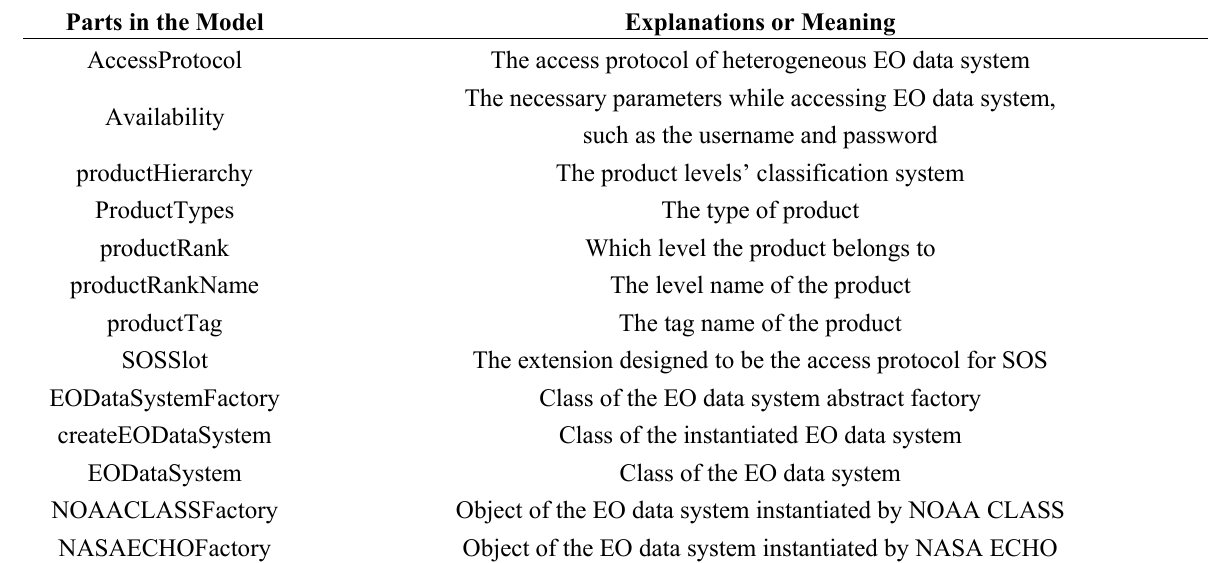
Table 2. The acronyms or model parts and